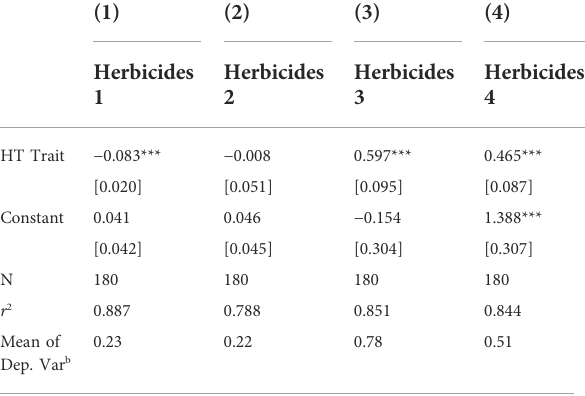
Models (1) and (2): kg/ha of active ingredients of herbicides and total pesticides. Models (3) and (4): fi eld EIQ, for herbicides and total pesticides. Restricted sample: farms that use both conventional and HT, seeds. Robust standard errors in brackets.